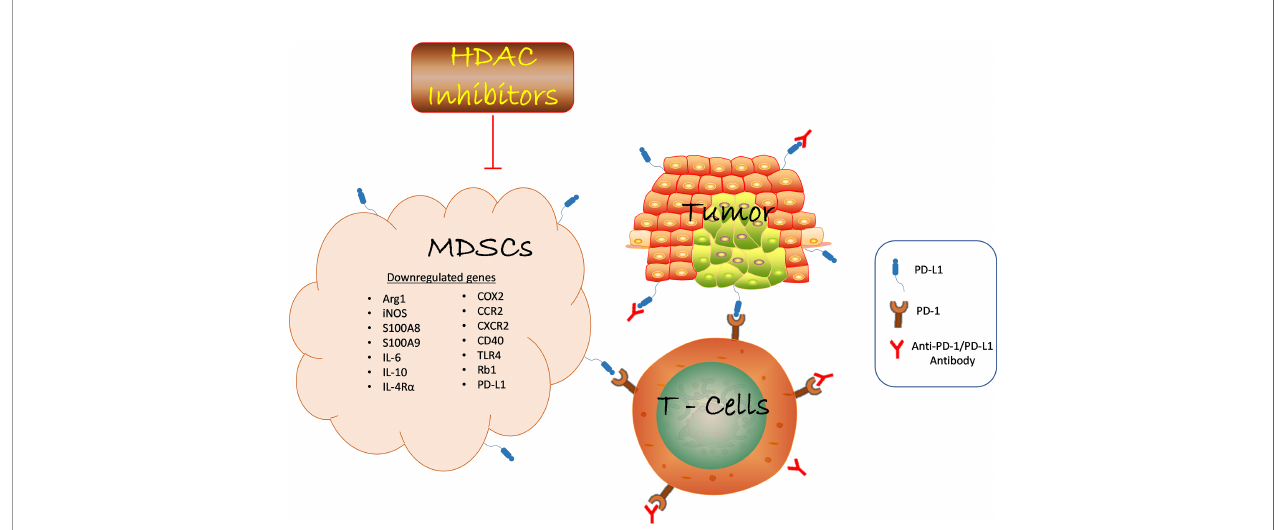
FIGURE 1 | HDAC inhibition suppresses MDSCs function in the TME and promotes anti-PD-1/PD-L1 tumor immunotherapy. HDAC inhibition blocks tumor- in fi ltrating MDSCs accumulation in various cancer by downregulating the expression of genes involved in promoting the suppressive role of MDSCs which led to reduced tumor growth. Anti-PD-1/PD-L1 antibody inhibits immune checkpoint proteins expression on tumor and T-cell to confer anti-tumor effect. The combination of HDAC inhibitors and anti-PD-1/PD-L1 promotes T cells activation to inhibit tumor growth. Likewise, HDAC inhibitors augment anti-PD-1/PD-L1 tumor immunotherapy via reduced MDSCs function. Hence, the interaction of several immune cells within the TME determines the success of cancer immunotherapy strategies. HDAC, Histone deacetylase; MDSCs, Myeloid-derived suppressor cells; anti-PD-1/PD-L1, antibody against programmed death receptor 1/programmed death-ligand 1; ARG1, arginase 1; iNOS, inducible nitric oxide; IL-6, interleukin 6; IL-10, interleukin 10; IL-4R a , interleukin 4 receptor alpha; COX2, cyclooxygenase 2; CCR, C-C Motif Chemokine Receptor 2; CXCR - CXC chemokine receptor 2; TLR4, toll-like receptor 4; Rb1, retinoblastoma